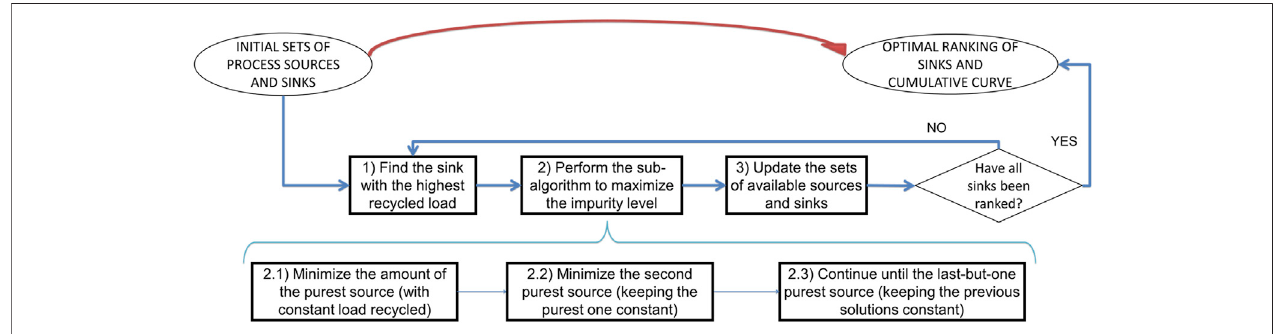
FIGURE 1 | Flowchart describing the sequential mass integration approach without rigorous. process modelling (SMI NPM ): out of an initial set of process sources and sinks an optimum order of process sinks (OSK NPM ), the respective cumulative curve up to the total recycling target (RT NPM ) and the recycling network (RN NPM ) are calculated by preemptive goal programming on the basis of a succession of linear programming